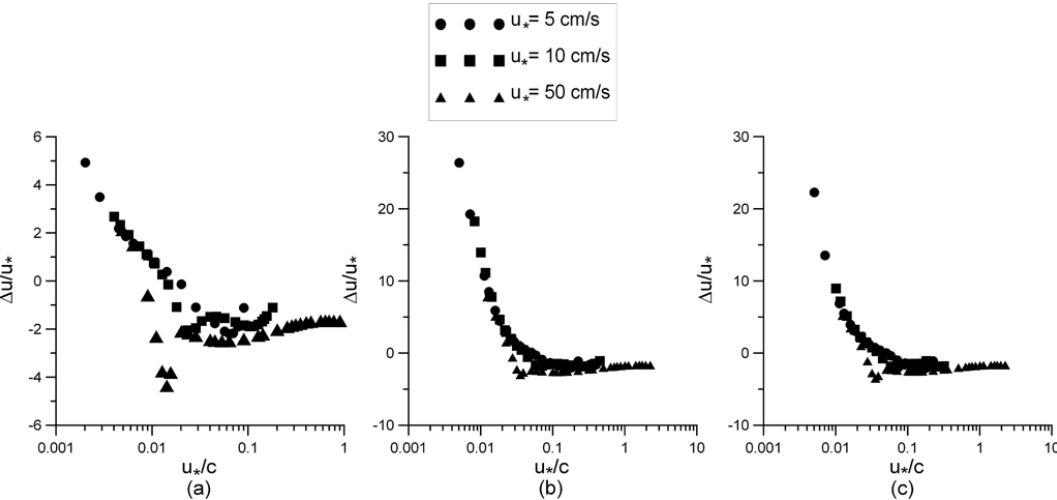
Fig. 6. Dependencies of the normalized nonlinear additives to the wind velocity 1u/u ∗ on wave age in stable (a) , neutrally stable (b) and